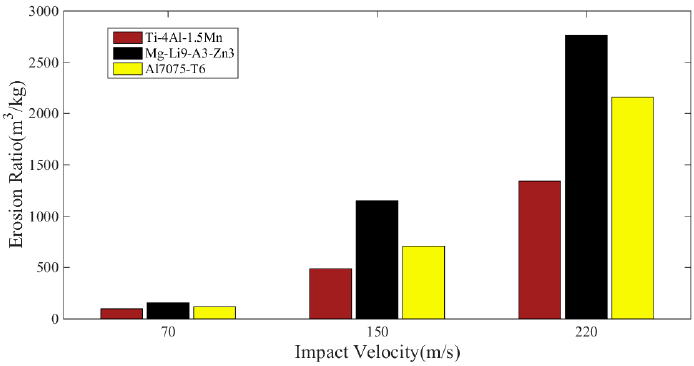
Table 4. Materials and parameters with bionic coatings.